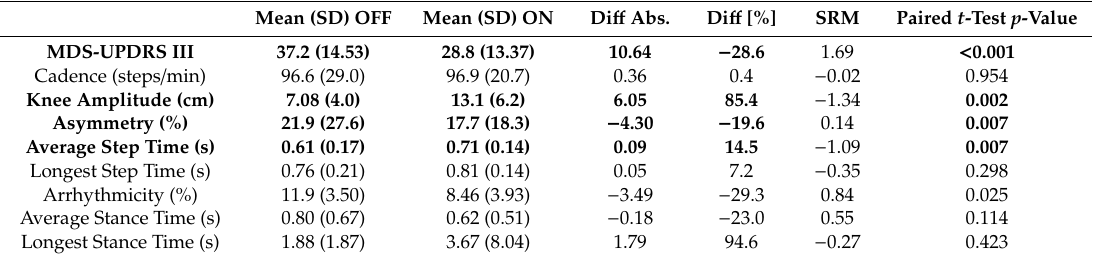
Table 5. Changes in SIP parameters and clinical rating from OFF to ON state in the subset with assessments in both conditions available ( n = 10).